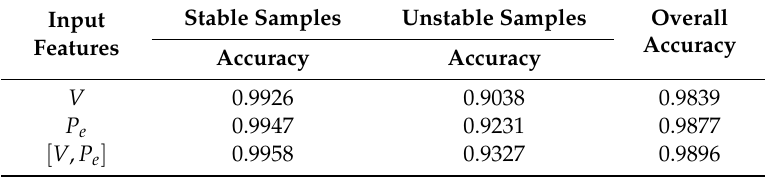
Table 5. Comparison of di ff erent sets of input features.